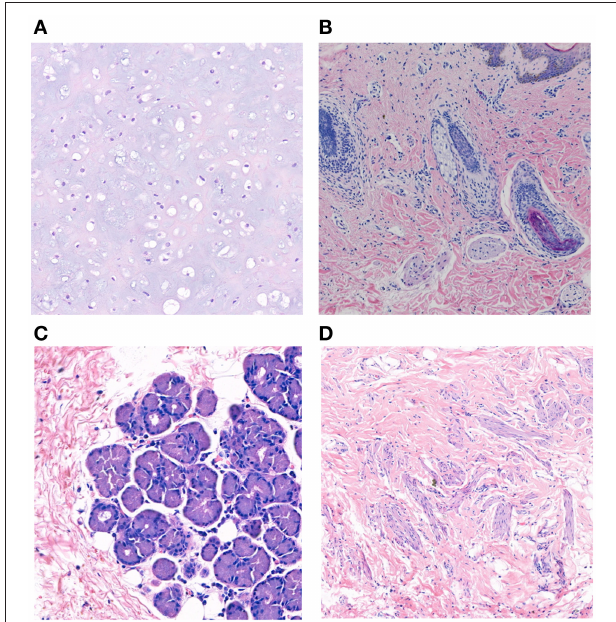
FIGURE 4 | Histopathological studies of complex choristoma cases. The complex choristoma was composed of cartilaginous tissue (patient 7) (A) . Immature hair follicle tissues combined with sebaceous glands were found in the biopsy of conjunctival lesions (patient 24) (B) . The complex choristoma contained lacrimal gland tissue (patient 9) (C) . The large complex choristoma contained both fibrous connective tissue and smooth muscle (patient 11) (D) (hematoxylin-eosin-stained, × 20 original